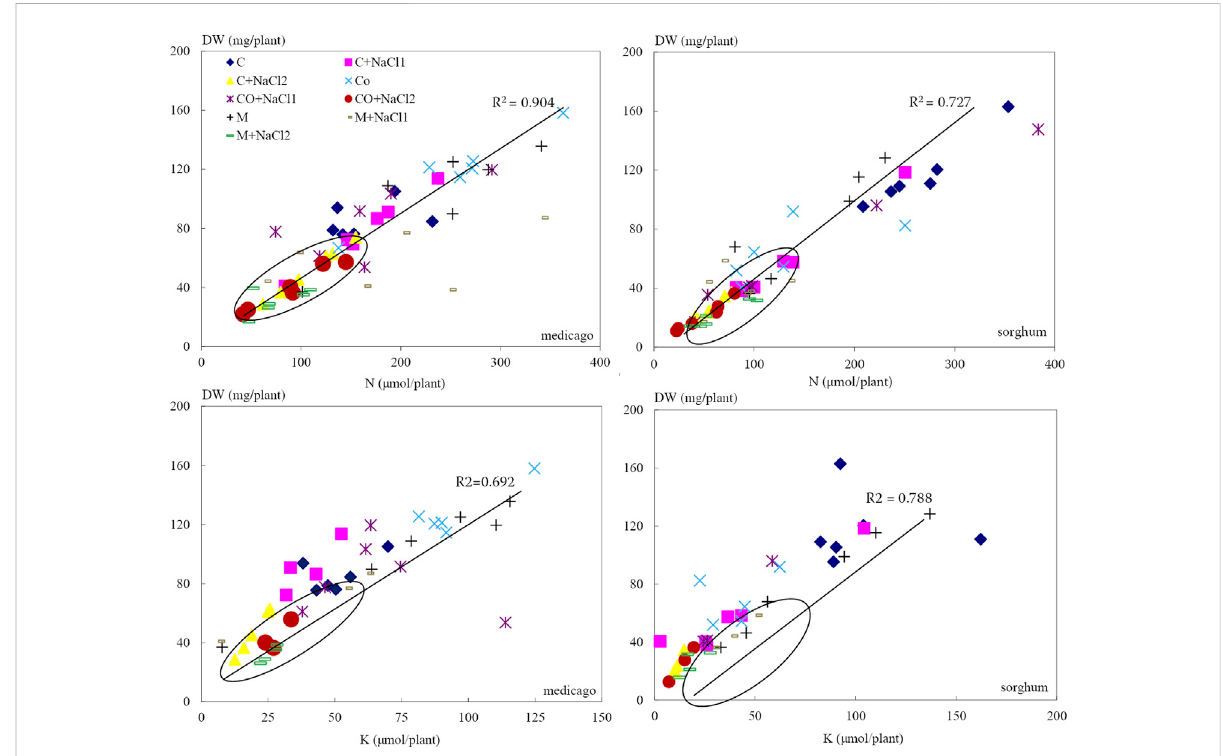
FIGURE 2 Relationship among the nitrogen and potassium uptake and dry weight yield of alfalfa and sorghum